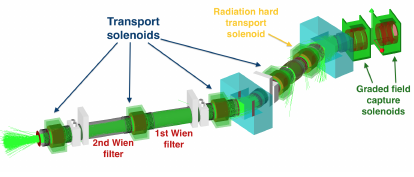
Figure 10. MUH3 beamline model in G4beamline [16]. TgH is positioned be- tween the two capture solenoids on the left. The muon beam (blue lines) is delivered to the entrance of the experimental area by the solenoid-only section, to then continue through the quadrupole channels. The two branches MUH3.2 and MUH3.3 are served by a septum magnet.